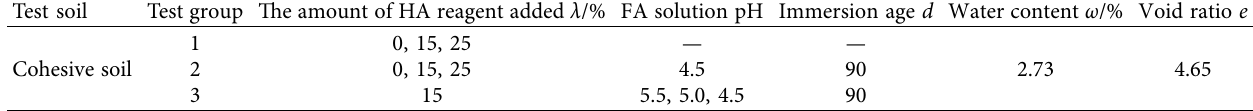
Table 3: Simulation test conditions of PSE.